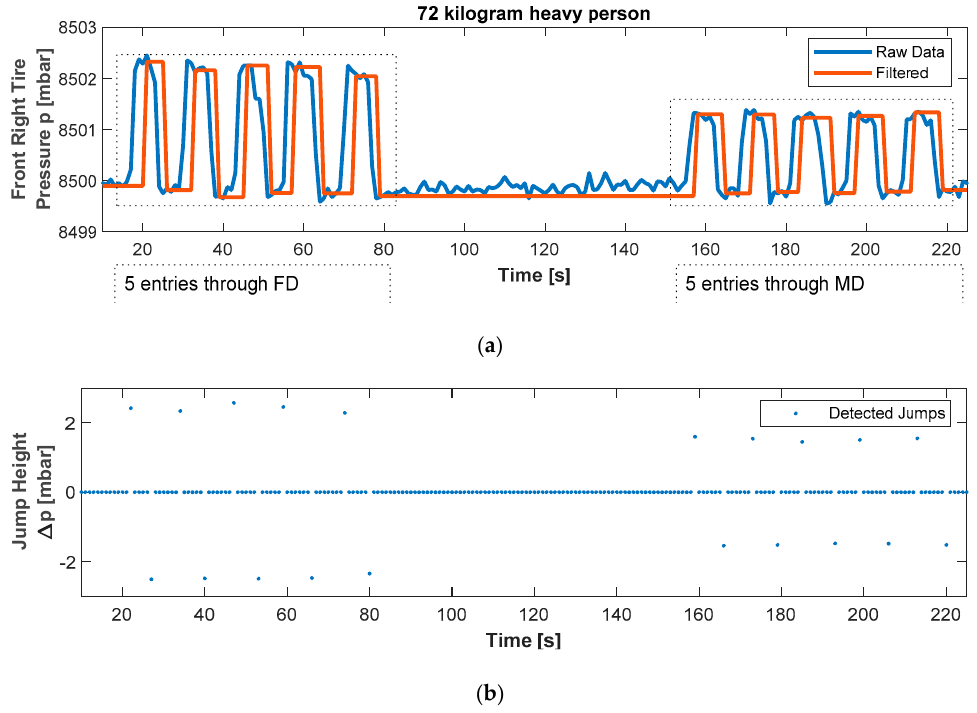
Figure 8. Raw and filtered data curves ( a ) and corresponding detected pressure steps from the algorithm ( b ) for five entries each in the front and middle door (bus).